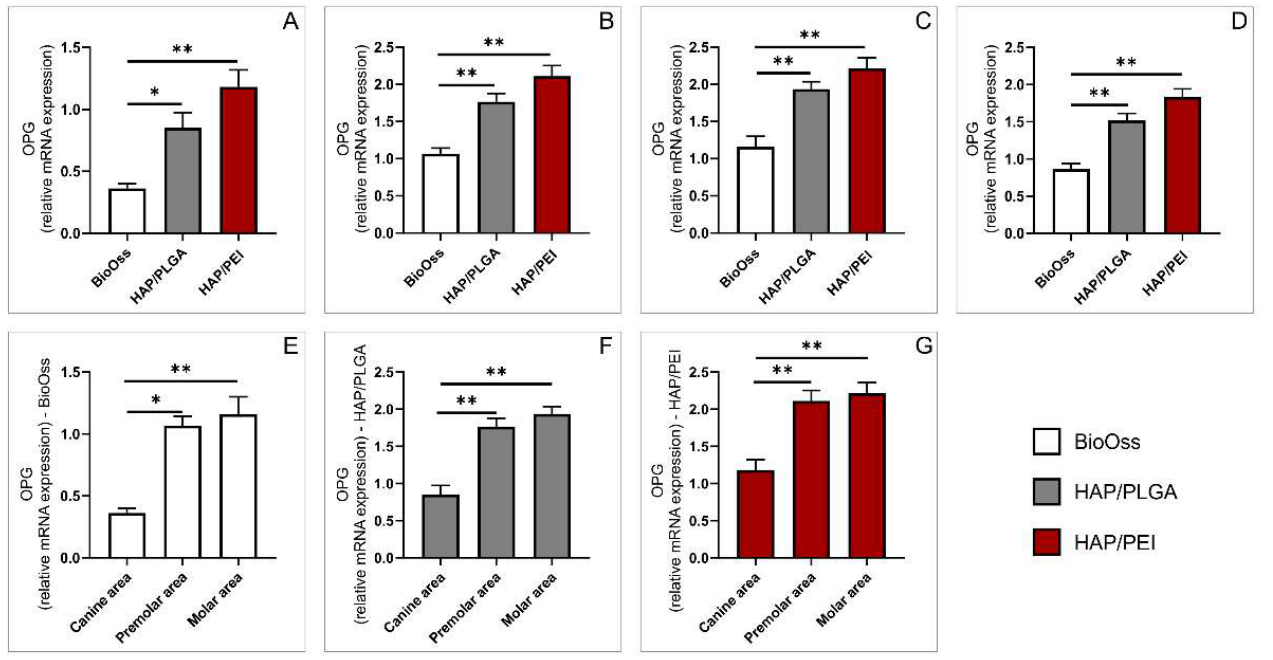
Figure 7. Relative expression of OPG gene: ( A ) canine area, ( B ) premolar area, ( C ) molar area, ( D ) whole mandibula, ( E ) BioOss graft, ( F ) HAP/PLGA graft, ( G ) HAP/PEI graft. The values are mean ± standard error of the mean (SEM), * denotes a significant difference p < 0.05, ** denotes a significant difference p < 0.01.